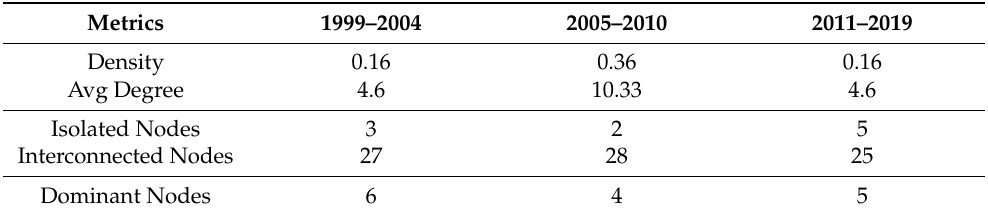
Table 7. Network metrics for 0.8 threshold level on the Imports of Goods and Services (% of GDP) variable.